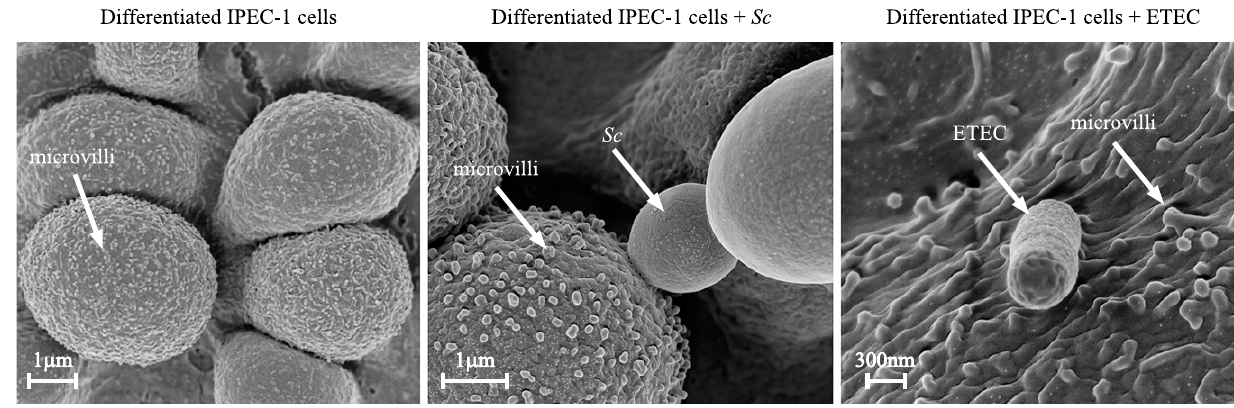
Figure 1. Interaction of Saccharomycescerevisiae or ETEC with differentiated IPEC-1 cells. Differentiated IPEC-1 cells were cultured overnight with Sc (3 6 10 6 yeasts/well) or exposed to ETEC (3 6 10 7 CFU/well) for 45 min. IPEC-1 cells were then assessed to scanning electron microscopy. (A) Differentiated IPEC-1 cells expressed microvilli on their surface, (B) Sc interacts with differentiated IPEC-1 cells, (C) ETEC interacts with differentiated IPEC-1